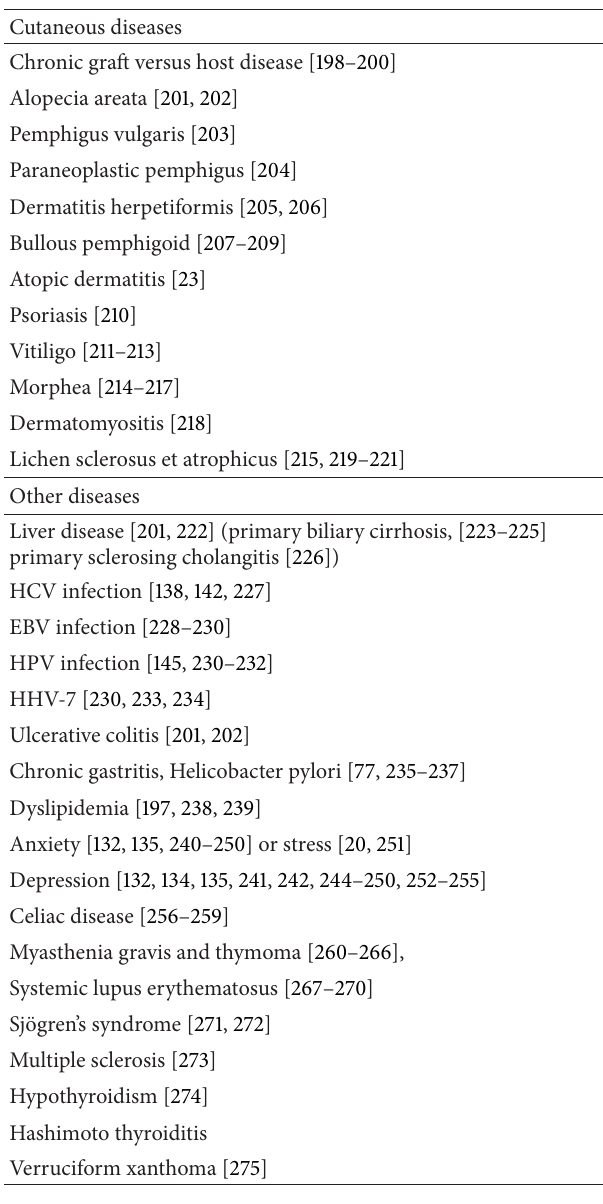
Table 7: Clinical associations of